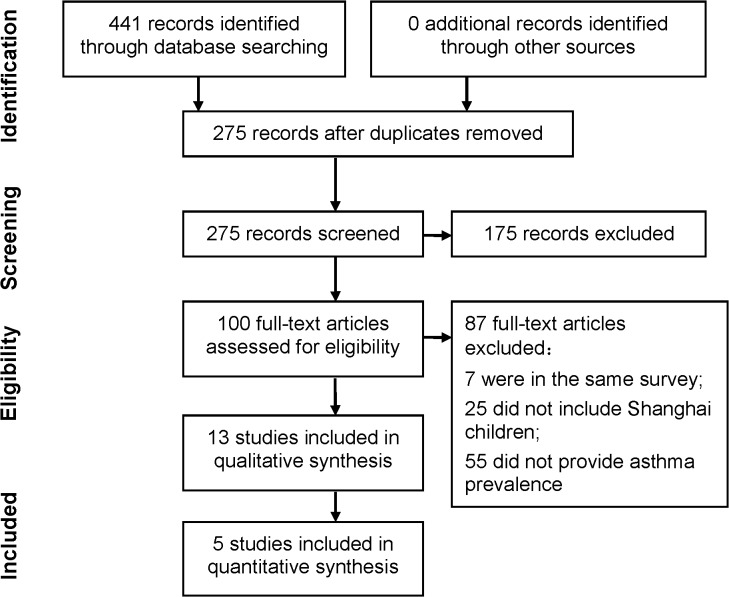
Flow chart of information of literature search through different phases (PRISMA flowchart).